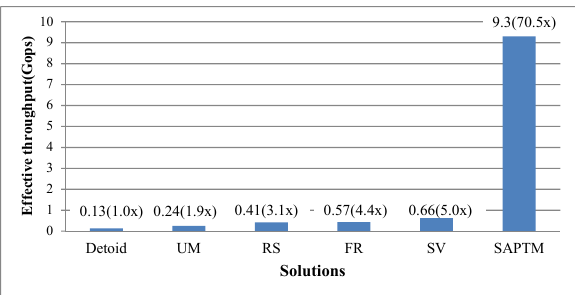
Figure 13. Comparison results of SAPTM with sketch-based solutions (effective